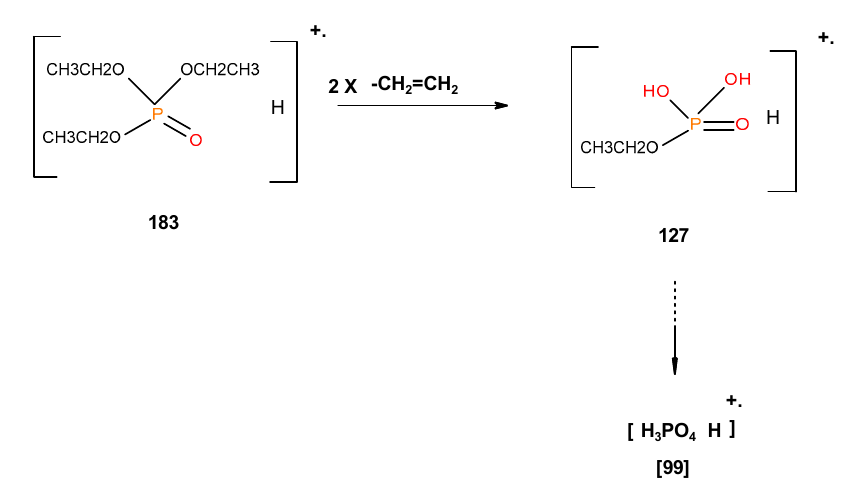
Figure 11. Possible fragmentation pattern for TEPi.